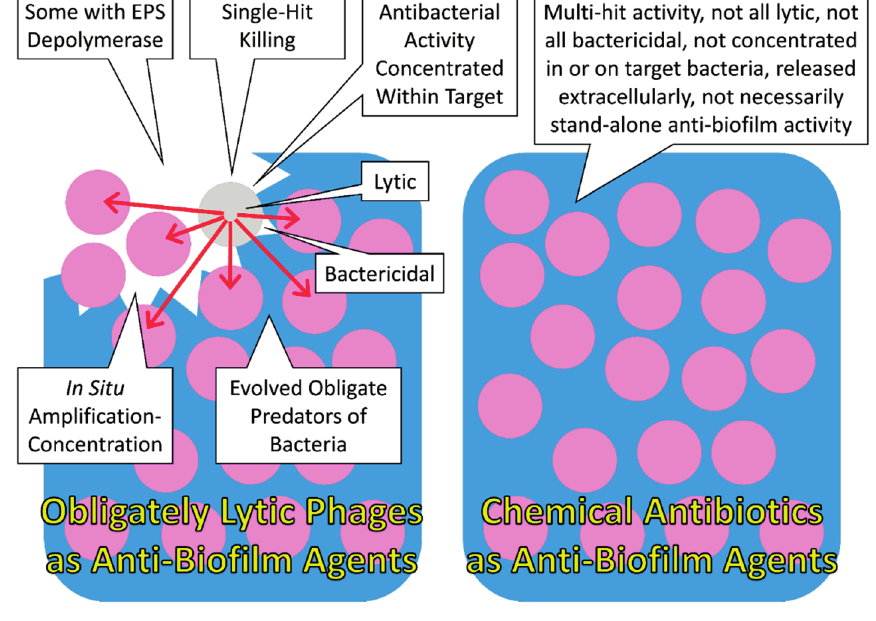
Figure 2. Overview of phage advantages as anti-biofilm agents in comparison to antibiotics. Bacteria are presented primarily as pink circles and extracellular polymeric substance (EPS) is represented as a blue background. Toward the upper left is a single, lysing, phage-infected bacterium, presented as a gray circle. Arrows emanating from that phage-infected bacterium represent free phages that have been produced, released, and which otherwise are diffusing towards neighboring phage-sensitive bacteria. The loss of blue background, as seen towards the upper-left of the figure, represents the action of EPS depolymerase. These depolymerase enzymes are displayed by phage virions and/or are released locally upon lysis from phage-infected bacteria. Callouts describe properties of obligately lytic phages versus antibiotics as anti-biofilm agents. See Table 3 for additional discussion of these